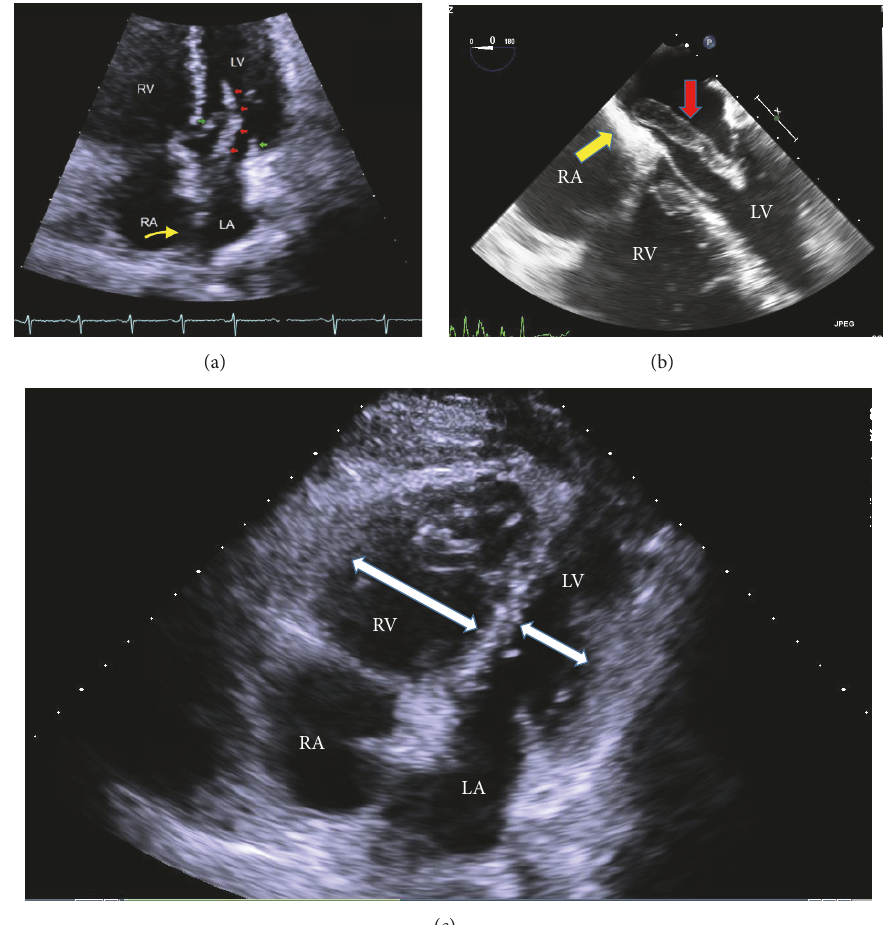
Figure 3: Echocardiography: (a) TTE apical four-chamber view demonstrating elongated LA thrombus (red arrows) prolapsing through PFO and LA into the LV during the diastole. Green arrows depict mitral valve leaflets. (b) The same clot is clearly visualized on TEE attached to interatrial septum. Yellow arrow depicts the location of PFO. (c) TTE subcostal view enlarged right heart chambers exceeding their left counterparts in